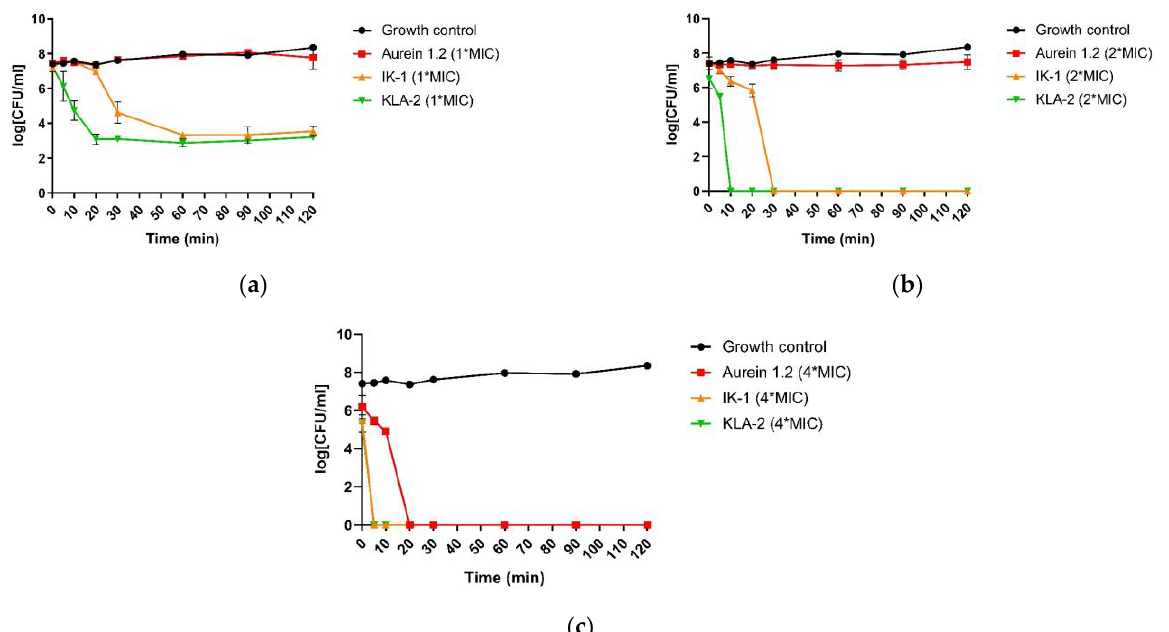
Figure 4. The kinetic killing curves of aurein 1.2, IK-1, and KLA-2 against S. aureus (ATCC 6538) at ( a ) MIC, ( b ) 2-fold MIC, and ( c ) 4-fold MIC. The error bars in the graphs around mean data points indicated the standard error of the mean (SEM) for each set of data in the nine replicates from three experiments.